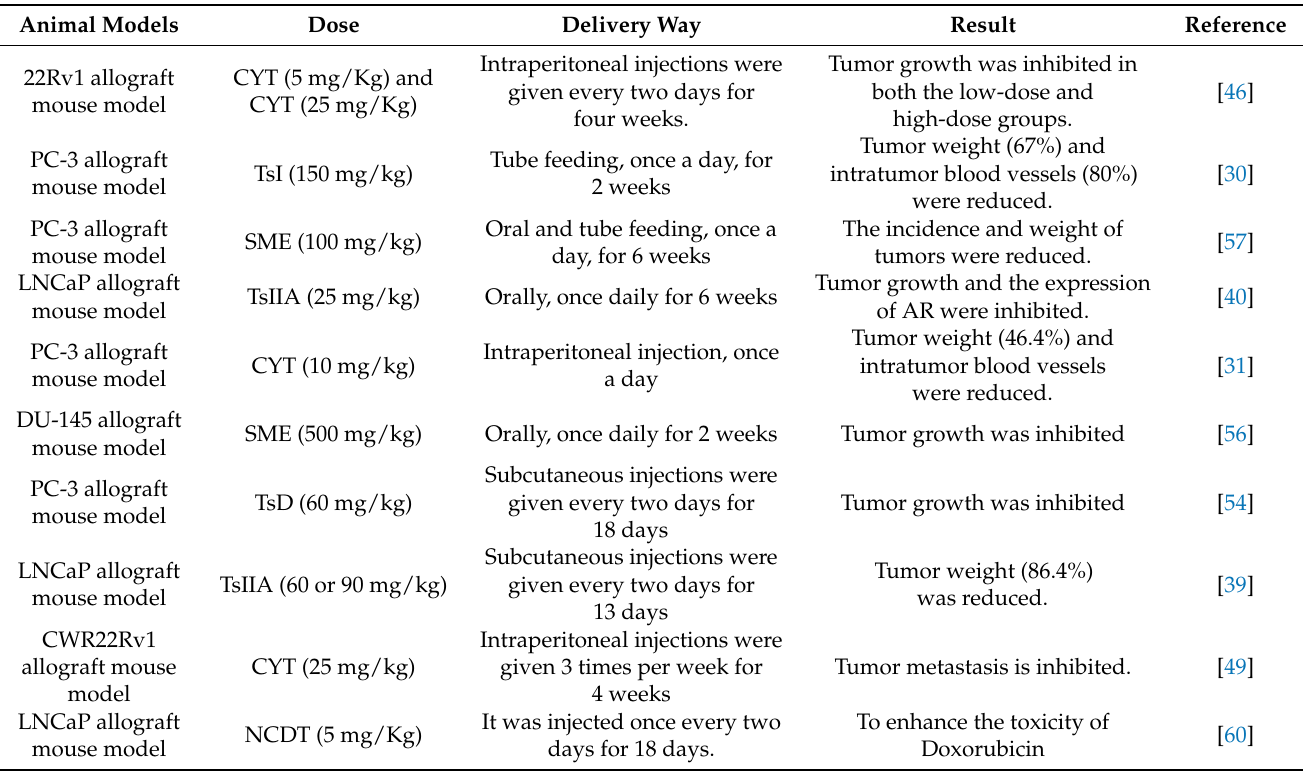
Table 2. In animal study of Tanshinone and